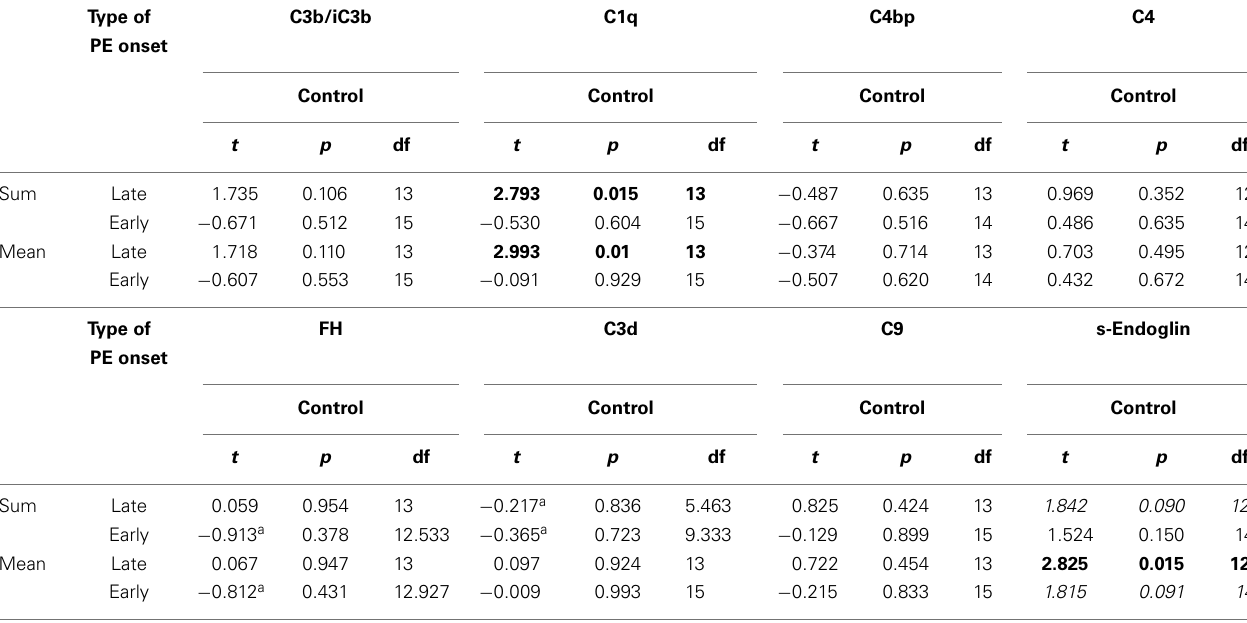
Table 4 | Complement and s-endoglin deposition in early- and late-onset preeclampsia (PE) vs. control